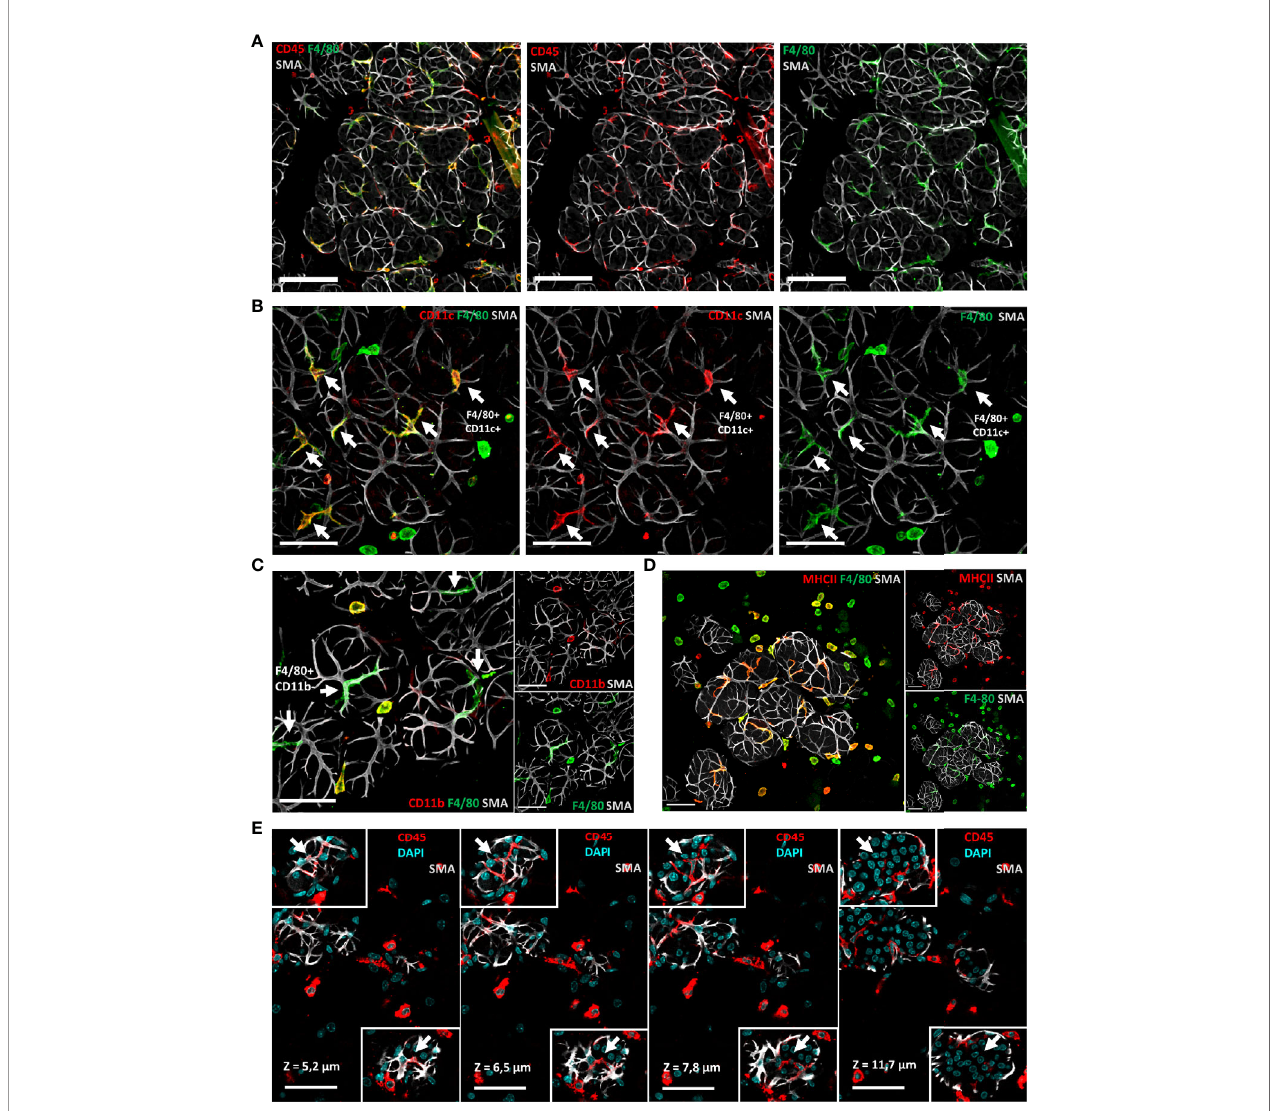
FIGURE 4 | Most macrophages around alveoli have a stellar shape and correspond to so-called ductal macrophages. (A – D) Three-dimensional maximum intensity projections (MIPs) of confocal microscopy images representative of optically cleared C57BL/6J lactating mammary glands. (A) Predominance of stellar-shaped F4/80 pos alveolar cells closely associated with SMA pos myoepithelial cells among mammary gland CD45 pos leukocytes. (B – D) F4/80 pos alveolar cells (white arrows) are CD11c pos , CD11b neg , and MHCII pos . (E) Four sequential optical slices (1.3 µm thick), in which the depth ( z value) is relative to the fi rst image in the sequence, showing the intercalary position of CD45 pos CD11c pos cells (white arrows) between the luminal and basal epithelial cells in two distinct alveoli. Scale bars = (A) 100 µm, (B – E) 50